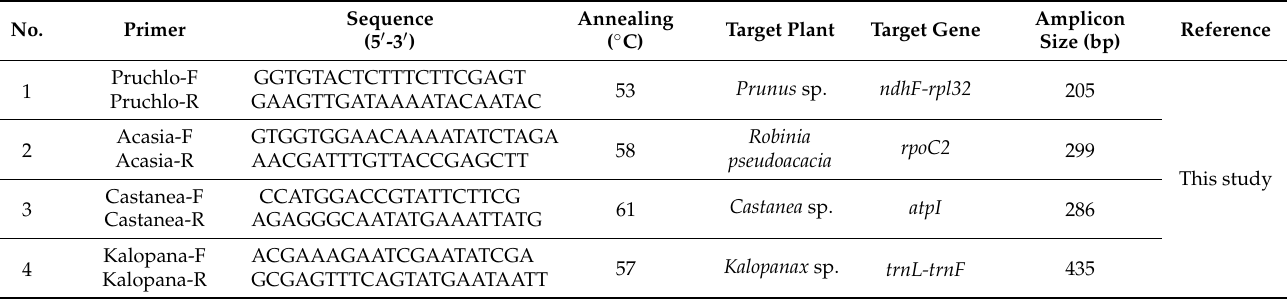
Table 2. Primers used for detection of seasonal nectar